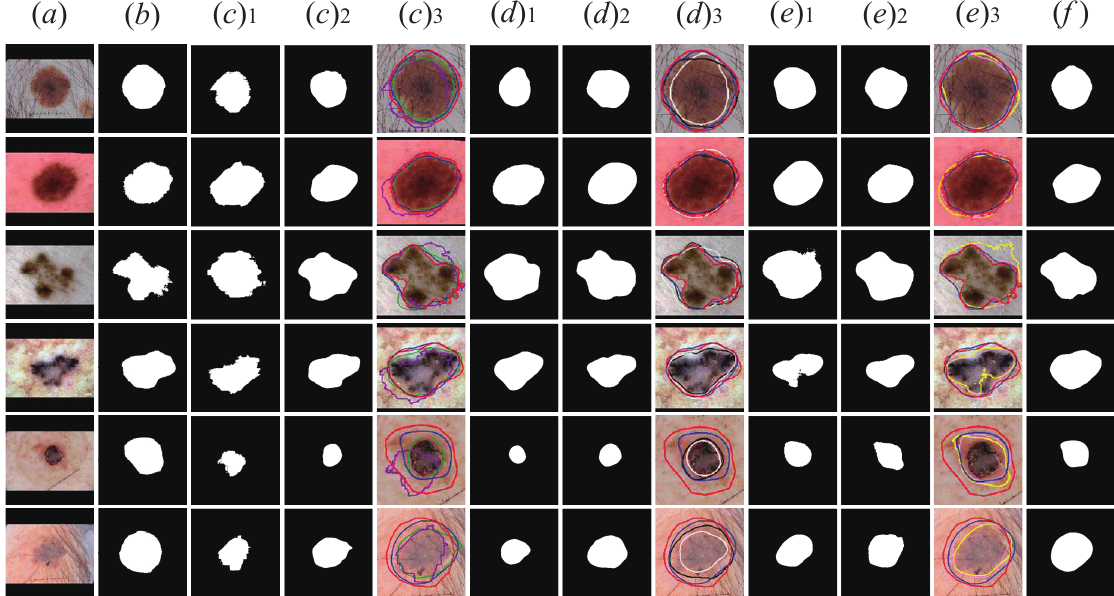
Figure 11. Visualization results of the robustness test of the CSAG module on the ISIC 2017 data set. The first two lines are Benign Nevus, the middle two lines are Melanoma lesions, and the last two lines are Seborrheic Keratosis lesions. ( a ) Original image; ( b ) the ground truth; ( c ) 1. U-Net; ( c ) 2. U-Net+CSFAG; ( c ) 3. Comparison of segmentation results ground truth (red), U-Net (purple), U-Net+CSFAG (green) and ours (blue); ( d ) 1. SegNet; ( d ) 2. SegNet+CSFAG; ( d ) 3. Comparison of segmentation results of ground truth (red) and SegNet (white), SegNet+CSFAG (black) and ours (blue) ( e ) 1. M-Net; ( e ) 2. M-Net+CSFAG; ( e ) 3. Comparison of segmentation results of ground truth (red) and M-Net (yellow), M-Net+CSFAG (pink) and ours (blue) ( f ) CSAG and DCCNet (ours) model. All pictures are